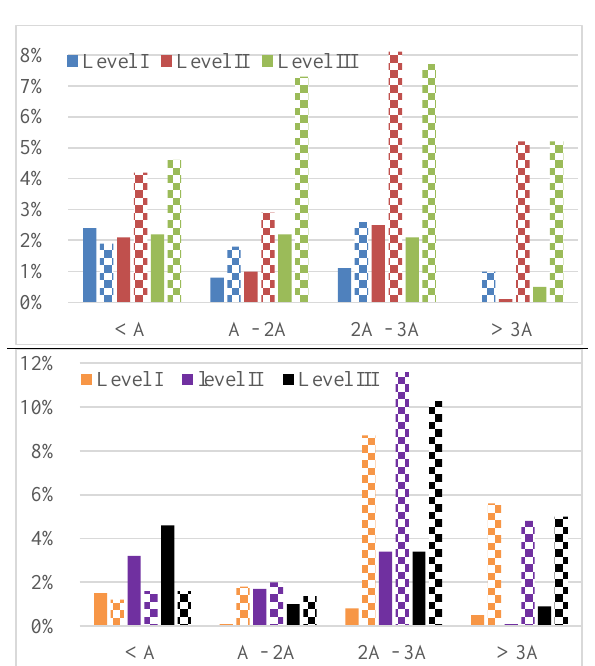
Figure 5: Differences of OA (top) and mF1 (bottom) between different network variants in Schleswig. Solid bars: differences between LuNet-lite-JO-ENS and LuNet- lite-JO-T ; checkered bars: differences between LuNet- lite-JO-ENS and LuNet-lite-JO-MS.